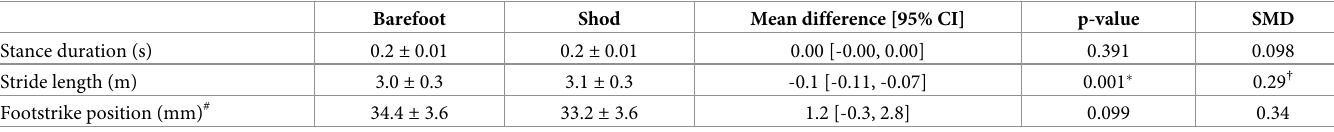
Table 1. Group mean ± SD values and the difference between footwear conditions for stride parameters and footstrike